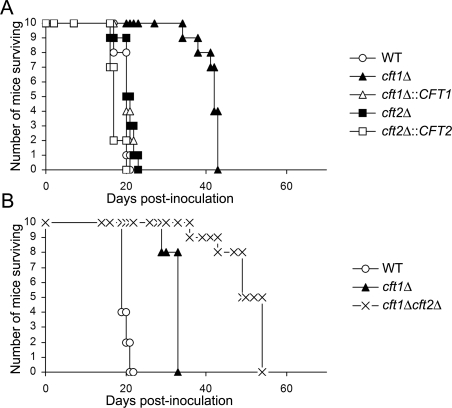
The cft1 and cft1 cft2 Mutants Are Attenuated for Virulence(A) Ten female A/Jcr mice were infected intranasally with each of the strains indicated and the survival of the mice was monitored over the time course indicated on the x-axis. The difference in survival between the cft1Δ mutant and the WT strain was significant based on a Kaplan-Meier survival analysis (p < 0.0001).(B) In a separate experiment, the virulence of the cft1Δ cft2Δ double mutant was compared with that of the WT strain and the cft1Δ mutant, again with 10 mice per inoculation. A second, independently isolated, double mutant showed a similar attenuation of virulence. All of the virulence tests were performed at least twice. The difference in survival between the cft1Δ mutant and the WT strain was significant (p < 0.0001), as was the difference between the cft1Δ mutant and the cft1Δ cft2Δ double mutant (p < 0.0001).